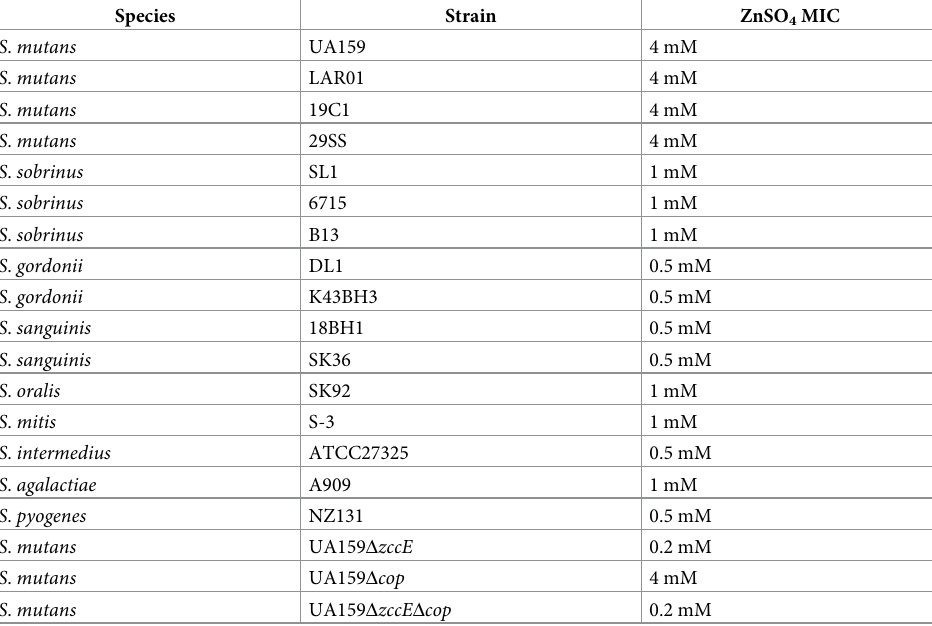
Table 1. ZnSO 4 MIC values of different streptococcal